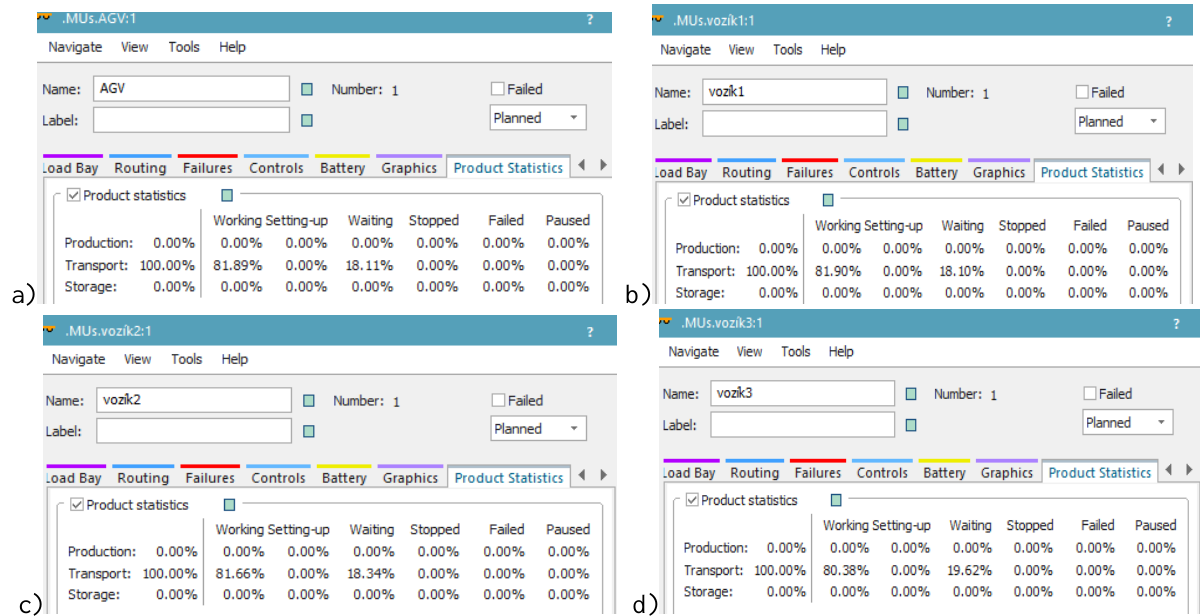
Figure 5: Statistical occupancy of the “AGV” vehicle and “transporter s” by cancelling of the transporter 4